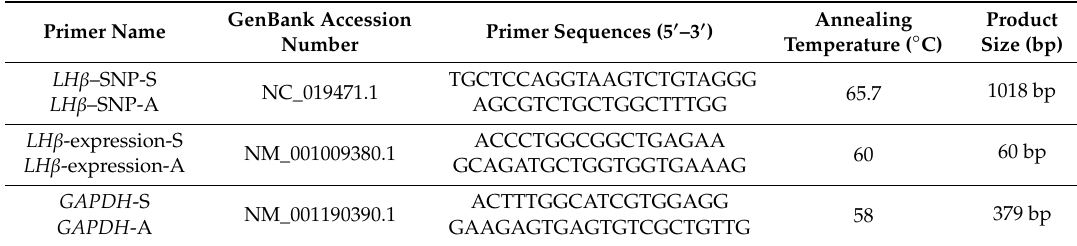
Table 1. Primer pairs designed for the sheep LH β and GAPDH